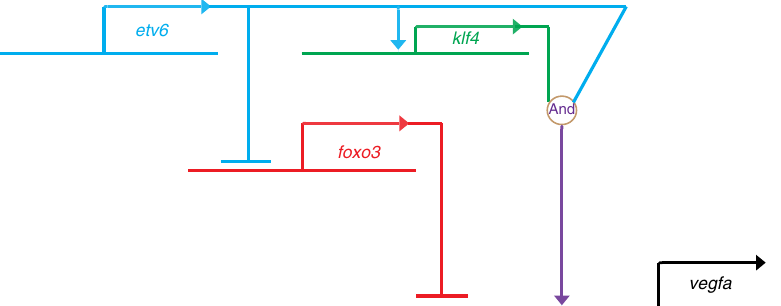
Fig. 7 GRN summarizing the mechanisms by which Etv6 regulates the expression of vegfa . Etv6 positively regulates vegfa expression in the somites through multiple mechanisms. It represses the transcription of foxo3 , a repressor of vegfa expression. In parallel, it activates the expression of klf4 , an activator of vegfa . Finally, Klf4 is required for Etv6 recruitment to the vegfa promoter to activate its expression. In conclusion, a network of positive and negative inputs from Etv6 is required for transcriptional activation of vegfa in the somites